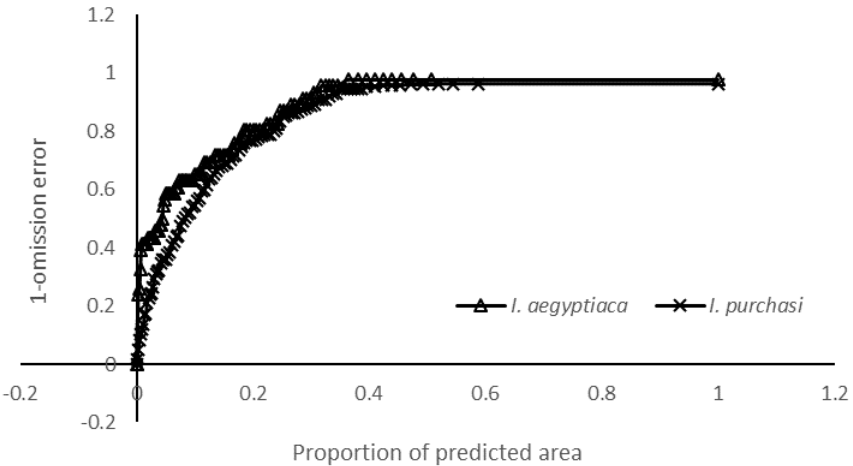
Figure 2. Illustration of receiver operating characteristic (ROC) curves at E = 0.05, the user-defined error tolerance.